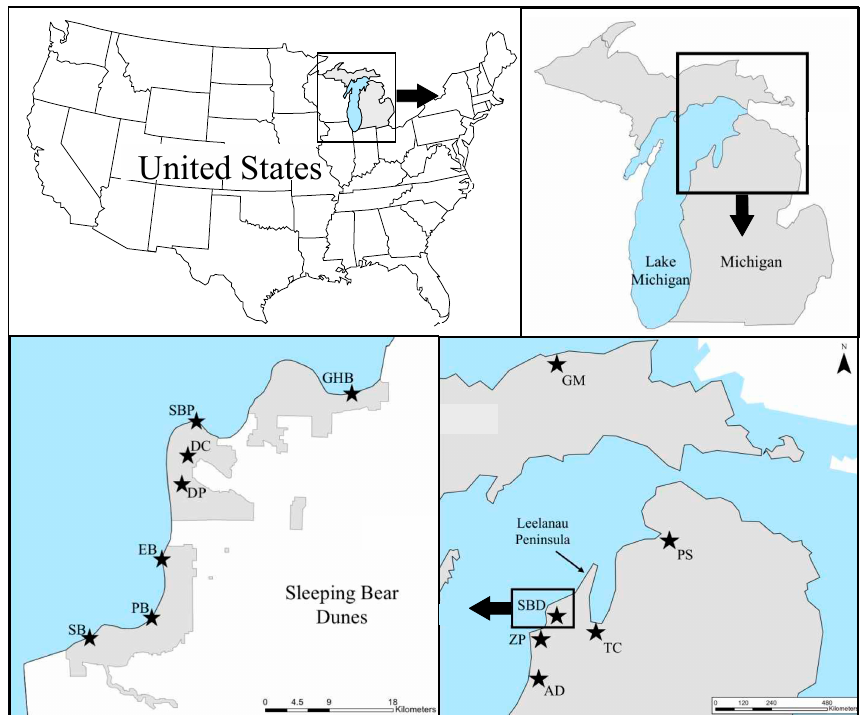
Figure 1. Map of Gypsophila paniculata sampling locations in Michigan. Seven were located throughout Sleeping Bear Dunes National Lakeshore. The park boundary is delineated by grey shading in bottom left panel. Sampling location codes: Grand Marais (GM), Petoskey State Park (PS), Traverse City (TC), Good Harbor Bay (GHB), Sleeping Bear Point (SBP), Dune Climb (DC), Dune Plateau (DP), Empire Bluffs (EB), Platte Bay (PB), South Boundary (SB), Zetterberg Preserve (ZP), Arcadia Dunes (AD).